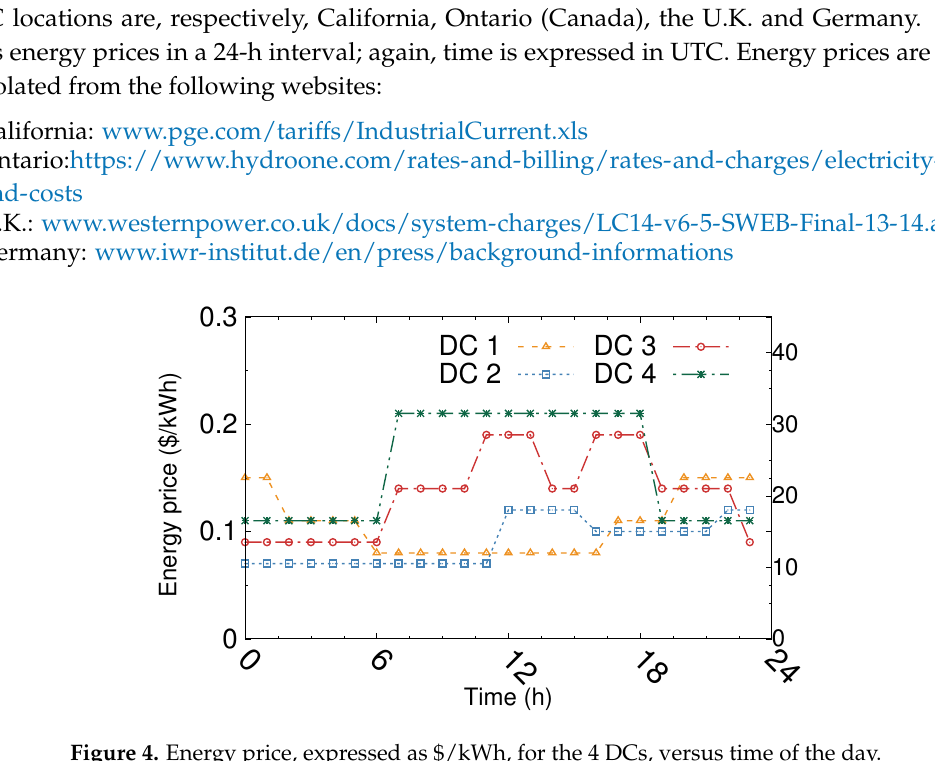
Figure 4. Energy price, expressed as $/kWh, for the 4 DCs, versus time of the